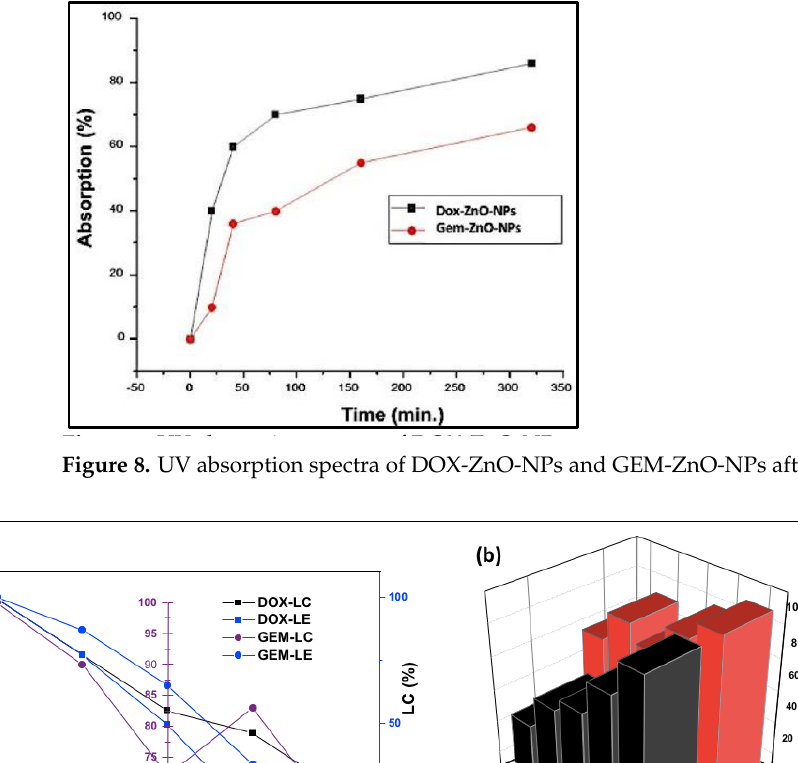
Figure 7. Absorption spectrum of ( a ) DOX-encapsulated ZnO-nanoparticles (DOX-ZnO-NPs), ( b ) GEM-encapsulated ZnO-nanoparticles (GEM-ZnO-NPs), ( c ) doxorubicin-encapsulated PEGylated nanoparticles (DOX-PEG-ZnO-NPs), and ( d ) GEM-encapsulated PEGylated nanoparticles (DOX-GEM-ZnO-PEGNPs (GEM-PEG-ZnO-NPs).